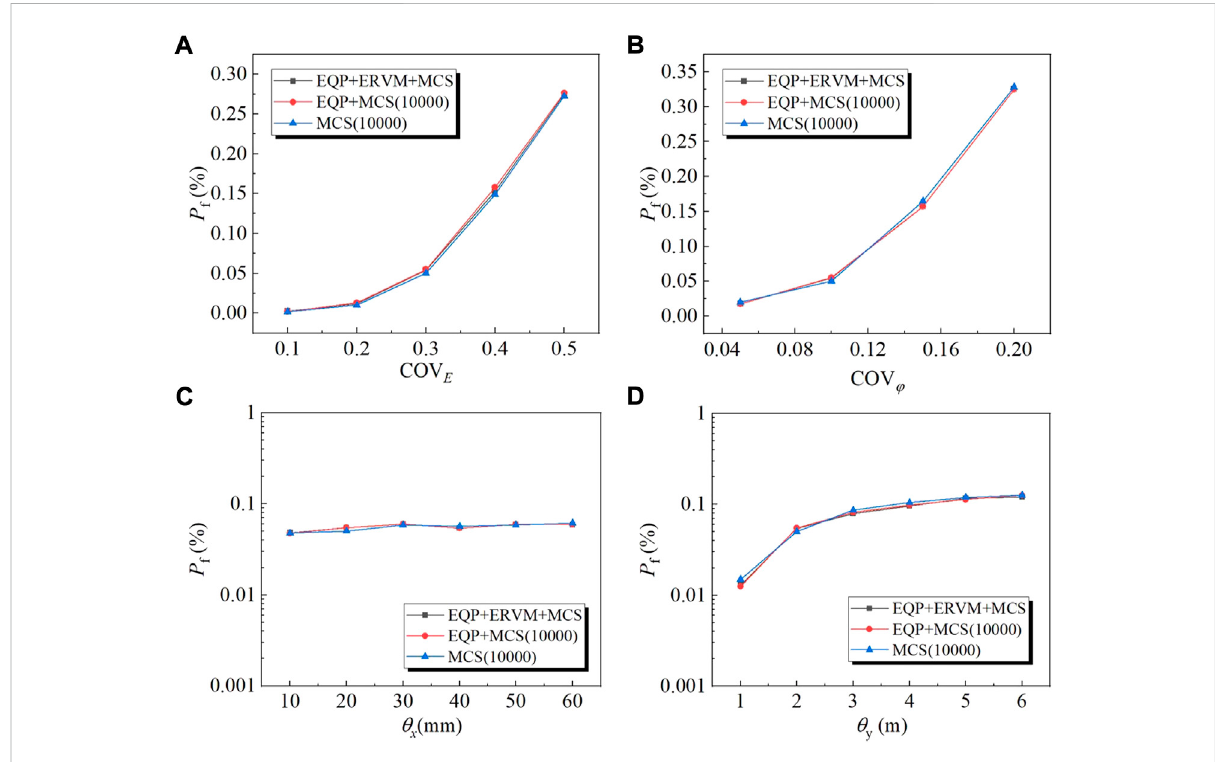
FIGURE 15 Parametric study on (A) COV E , (B) COV φ , (C) θ x , and (D) θ y